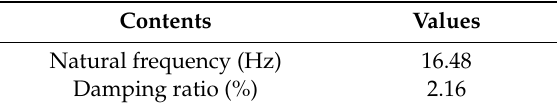
Figure 4. Transfer function of the electrical cabinet obtained from shaking table test. Table 2. Results of shaking table